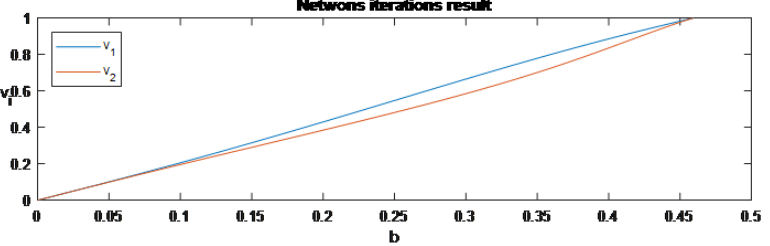
Fig. 2 Newtons iterations result of the two CDF/PDF bidders’ valuations